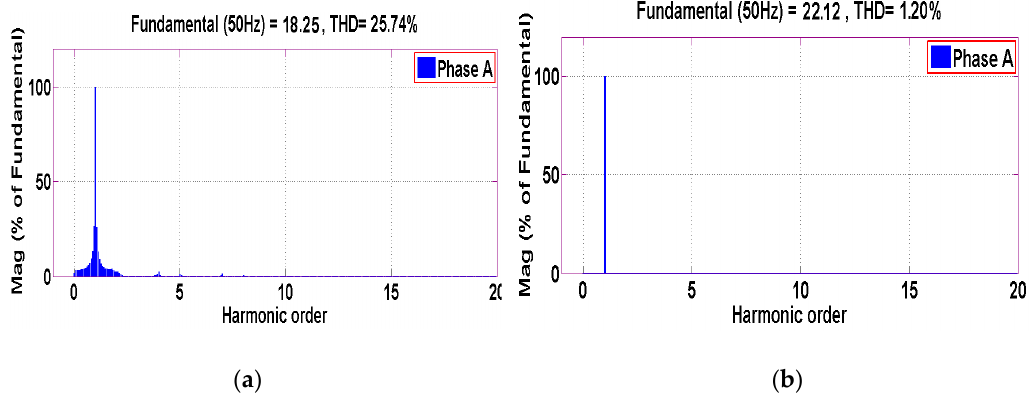
Figure 18. Simulation results under balanced voltages with unbalanced load: (a) THD level of load current before compensation; (b) THD level of source current after compensation.